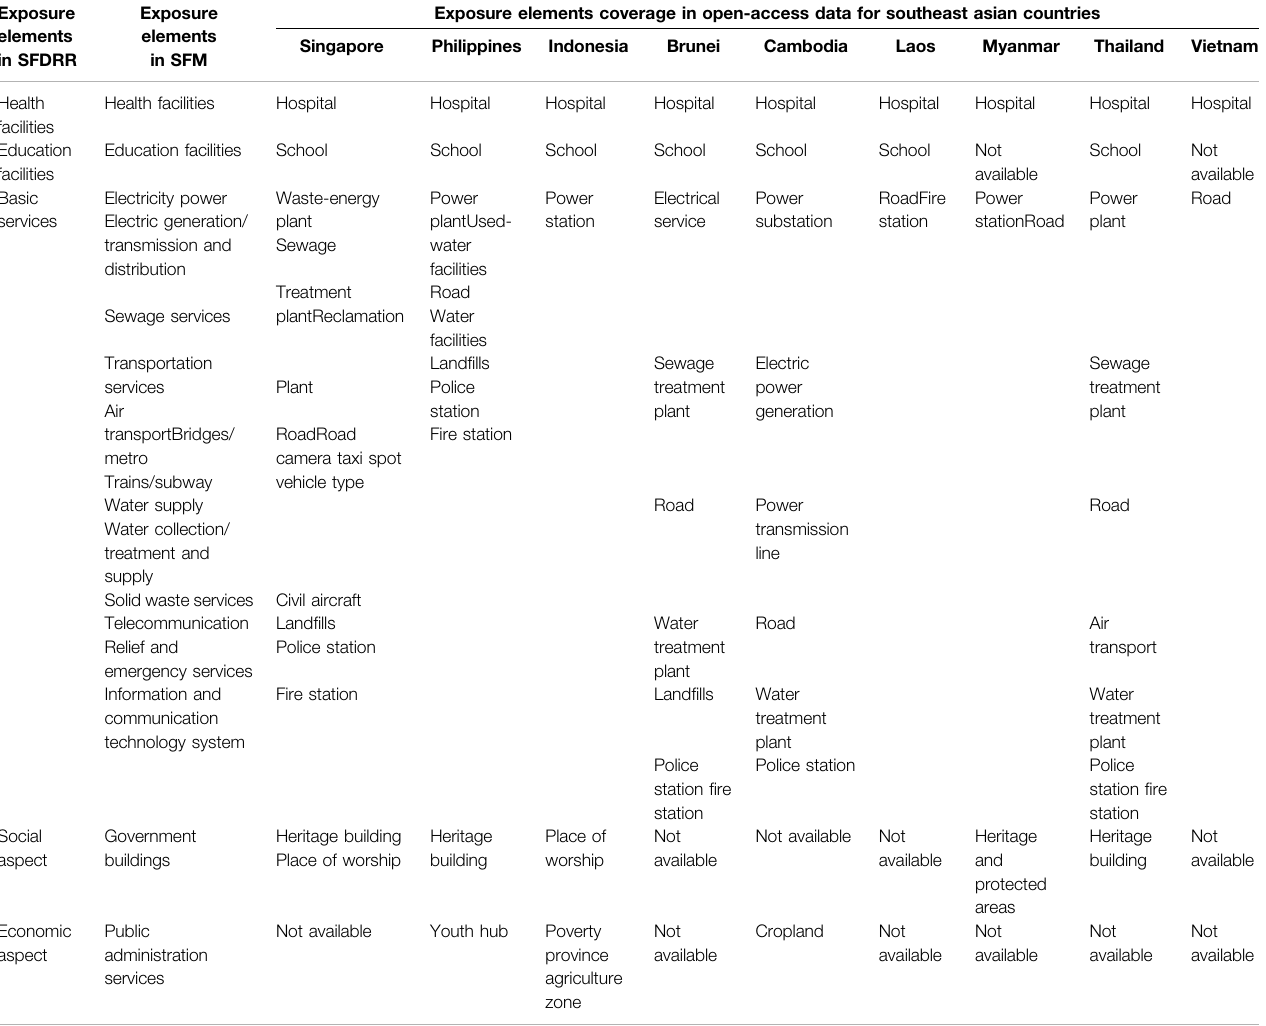
TABLE 4 | Coverage of information on exposure elements in southeast asia (as of January